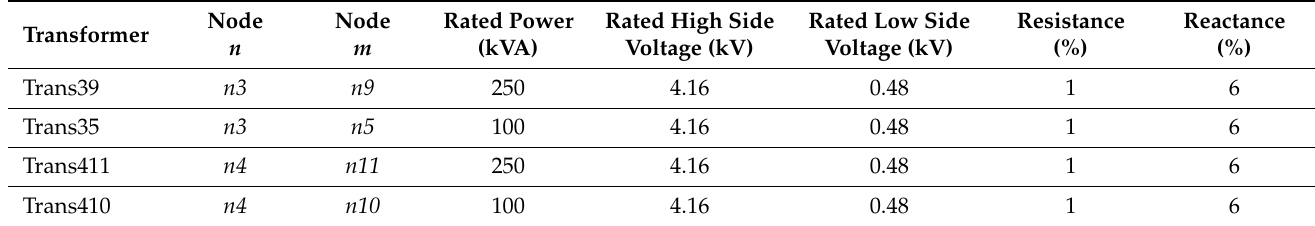
Table A2. Parameters of the PRO coupling and supply transformers.